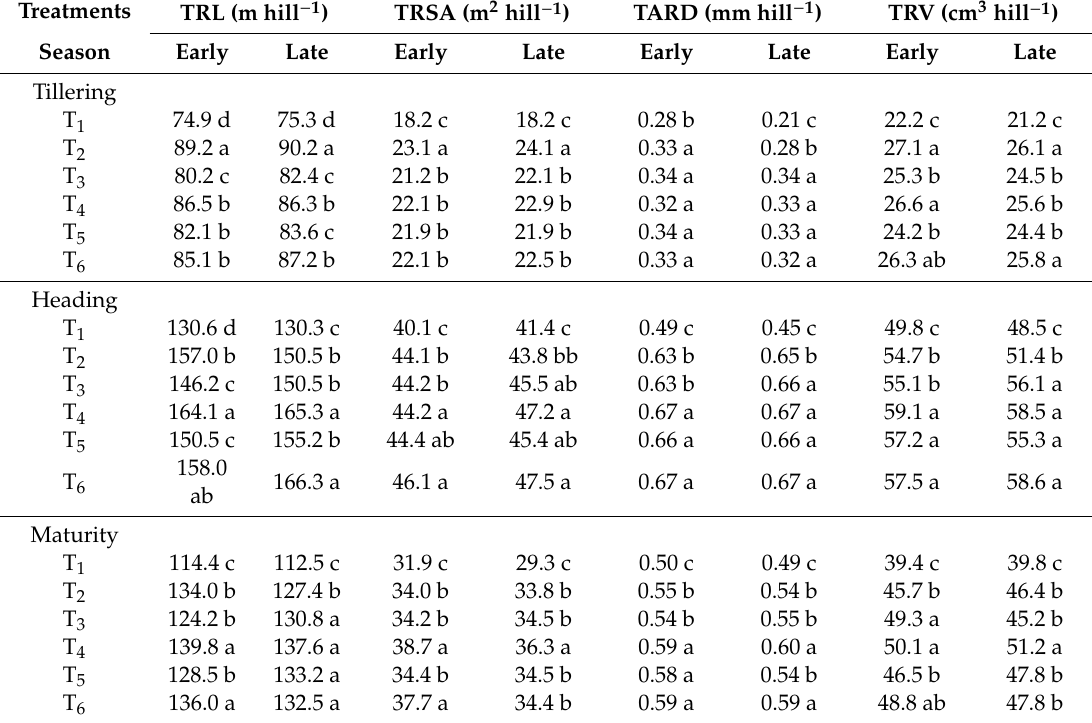
Table 6. Changes in root length, surface area, average diameter, and root volume under organic and inorganic